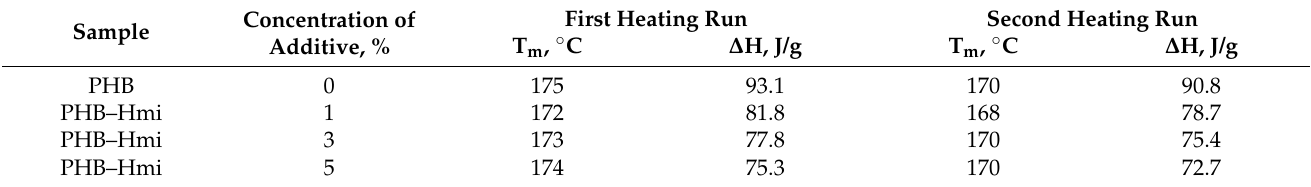
Table 4. Thermal properties of PHB–Hmi, where χ —crystallinity degree ∆ ± 2.5%, ∆ H—melting